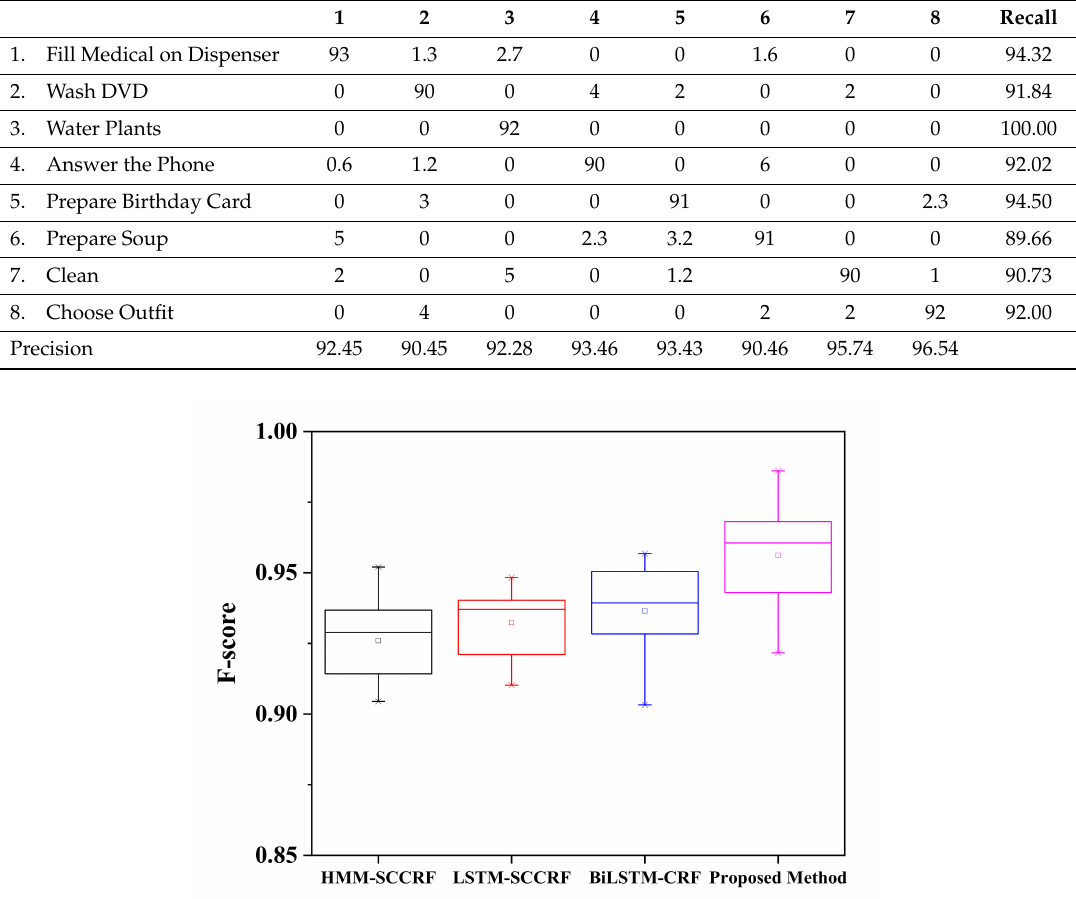
Table 4. Confusion matrix for Kyoto 3.